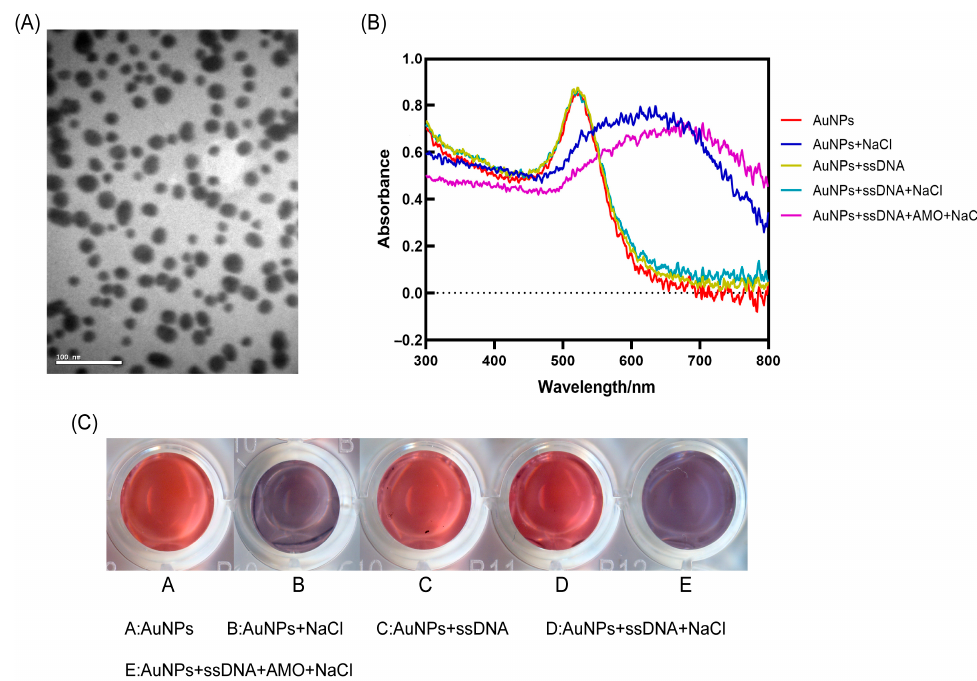
Figure 1. ( A ) Transmission electron microscopy results of AuNPs. ( B ) Spectral scan results when different components were present in the solution (AuNPs; AuNPs+NaCl; AuNPs+ssDNA; AuNPs+ssDNA+NaCl; AuNPs+ssDNA+AMO+NaCl). When AuNPs were dispersed, the absorption peak was around 520 nm, and the absorption peak was around 620 nm when aggregated. ( C ) Color changes when different components were present in the solution (AuNPs; AuNPs+NaCl; AuNPs+ssDNA; AuNPs+ssDNA+NaCl; AuNPs+ssDNA+AMO+NaCl).